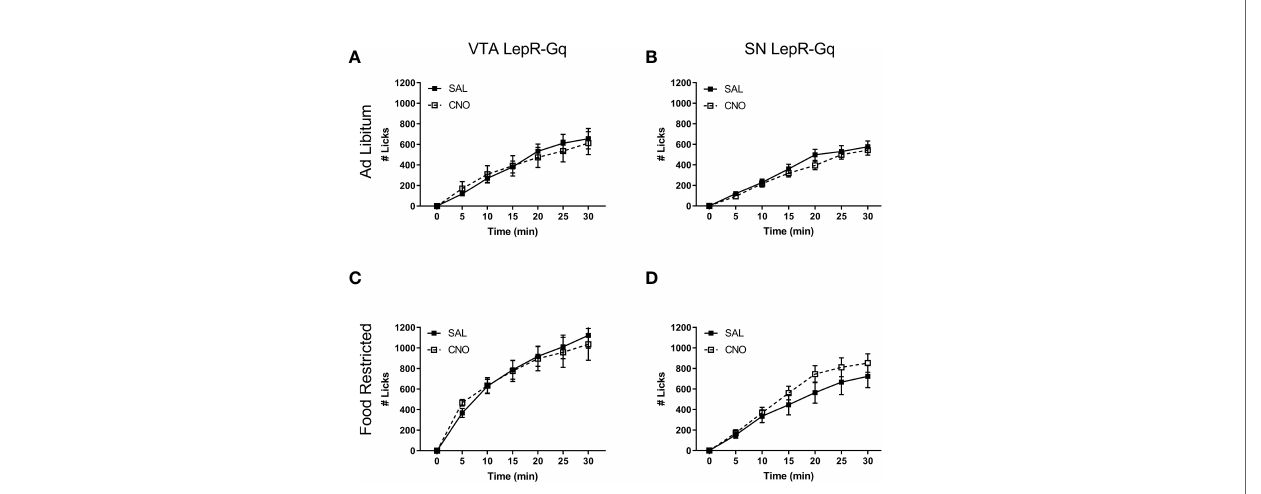
FIGURE 6 | Free 20% sucrose solution consumption upon chemogenetic activation of VTA LepR or SN LepR neurons. CNO (1.0mg/kg) did not affect sucrose solution consumption in ad libitum fed (A) VTA LepR-Gq (n=6) and (B) SN LepR- Gq (n=6) or food restricted (C) VTA LepR-Gq (n=6) and (D) SN LepR-Gq (n=6). Mean ± SEM.